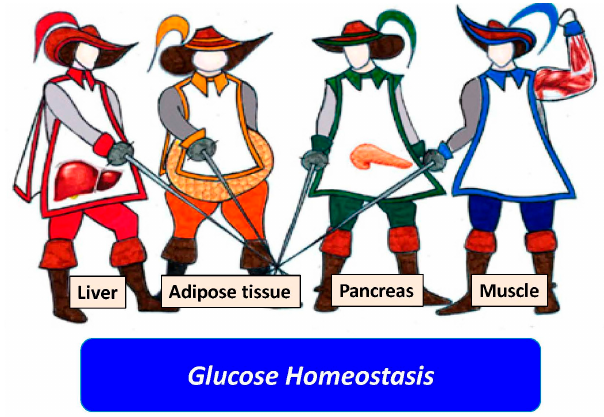
Figure 2. Liver as the fourth “musketeer”. This figure identifies adipose tissue, skeletal muscles, and pancreas as the three key organ systems controlling glucose homeostasis in humans. Together with these three organ systems, the liver also plays a key role in glucose disposal in health. Consistently, a large number of studies based on both the NAFLD and the hepatitis C virus (HCV)-related liver disease spectrum have highlighted the pathogenic role of the liver in the development of type 2 diabetes mellitus. (Modified from ref. [42]).